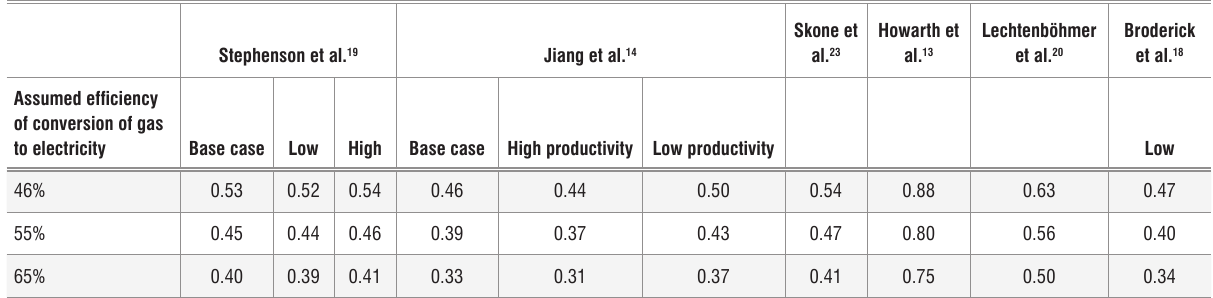
Calculated CO e/MWh electricity produced under different assumptions of combined cycle gas turbine efficiency using a 20-year global warming 2 potential for methane (own analysis)